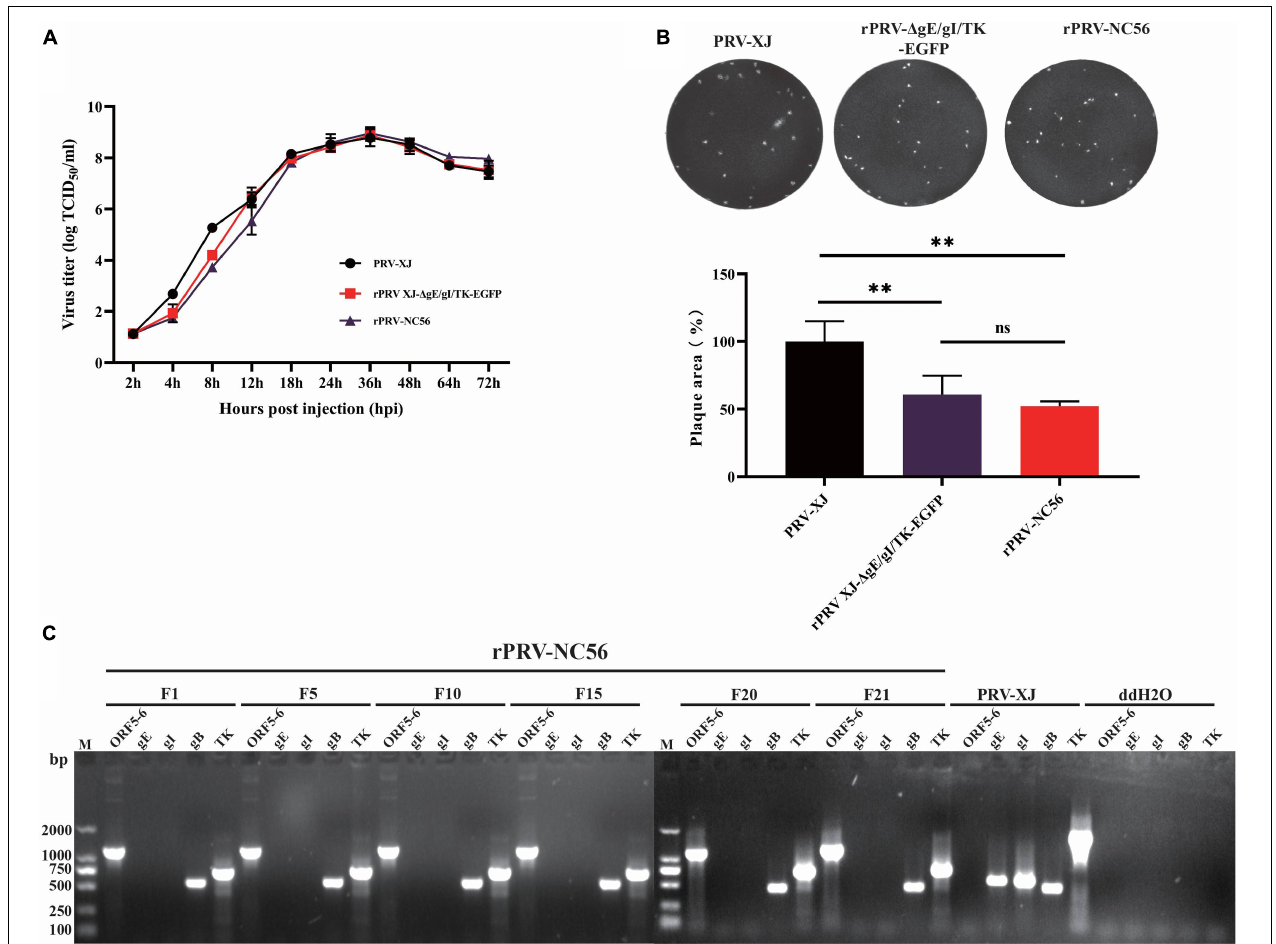
FIGURE 3 | Biological characterization of recombinant pseudorabies virus rPRV-NC56. (A) One-step growth curves of PRV XJ, rPRV XJ- (cid:49) gE/gI/TK-EGFP, and rPRV-NC56 in BHK-21 cells. (B) Comparison of plaque size of BHK-21 cells infected with PRV XJ, rPRV XJ- (cid:49) gE/gI/TK-EGFP, and rPRV-NC56. (C) PCR identification of gE, gI, gB, TK, and a partially inserted target gene (ORF5-6) in cell cultures from generations 1, 5, 10, 15, 20, and 21 of rPRV-NC56. ** p <